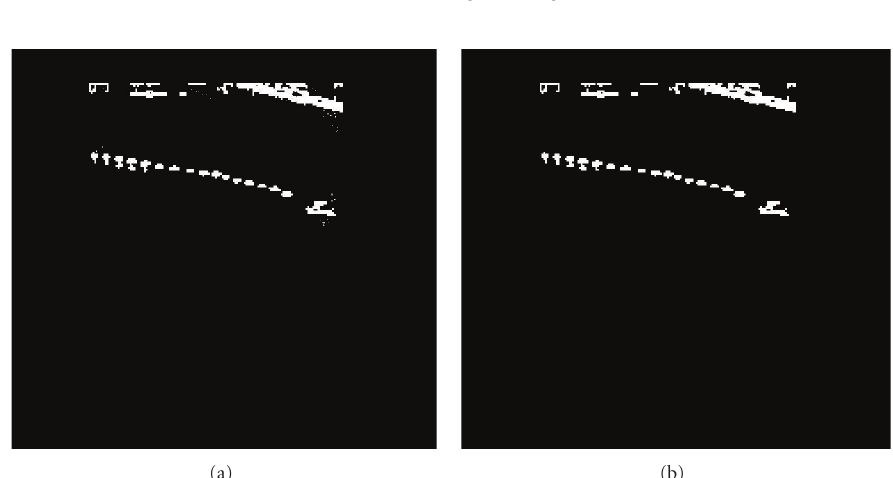
Figure 4: Image resizing.